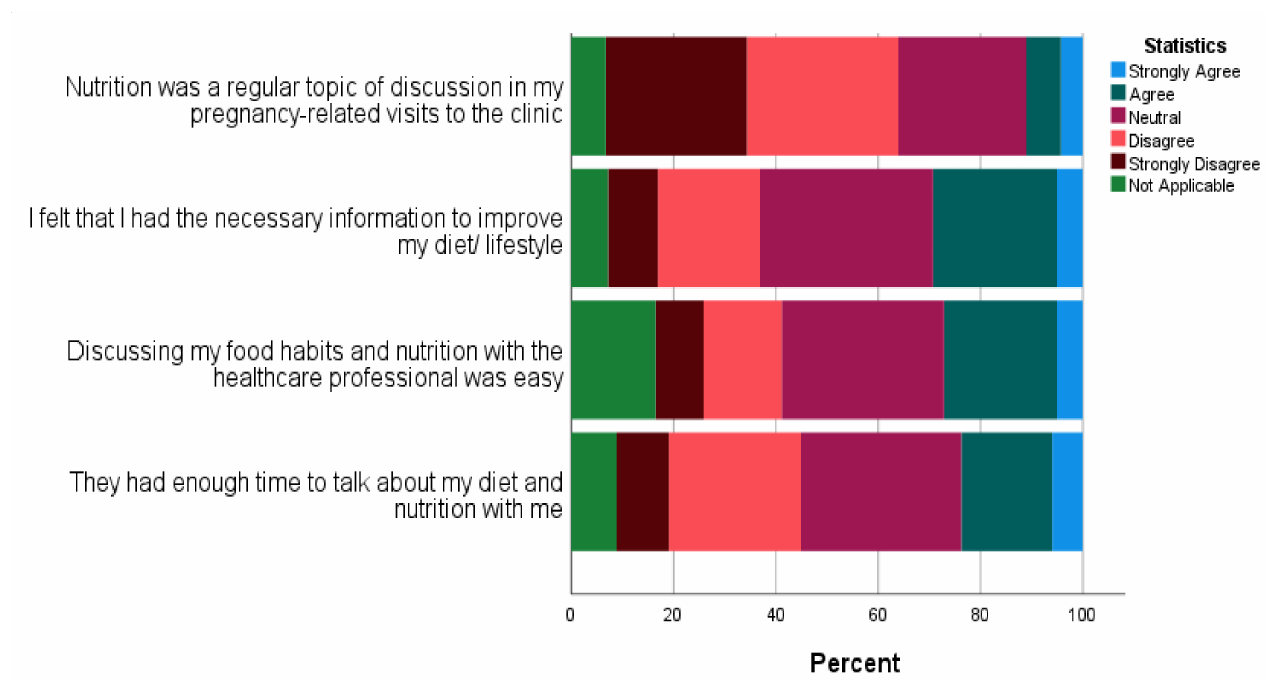
Figure 4. Stacked bar chart on experience of discussing nutrition and weight with HCPs based on the survey of women in the UK ( N = 236) (not applicable indicates that women responded that they were not pregnant/did not have a baby recently/were not thinking about a